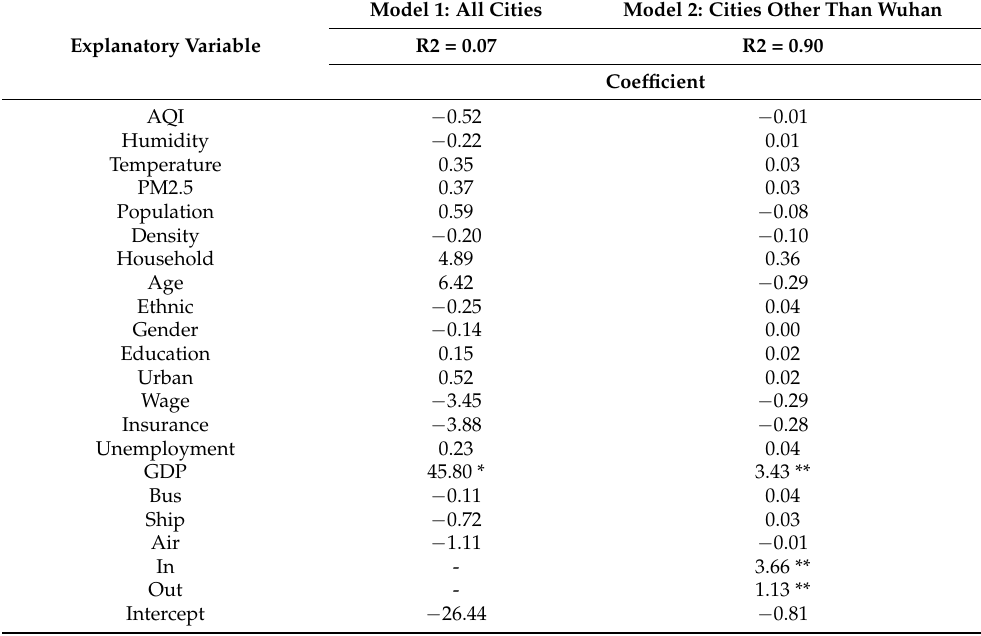
Table 2. Parameter estimates of